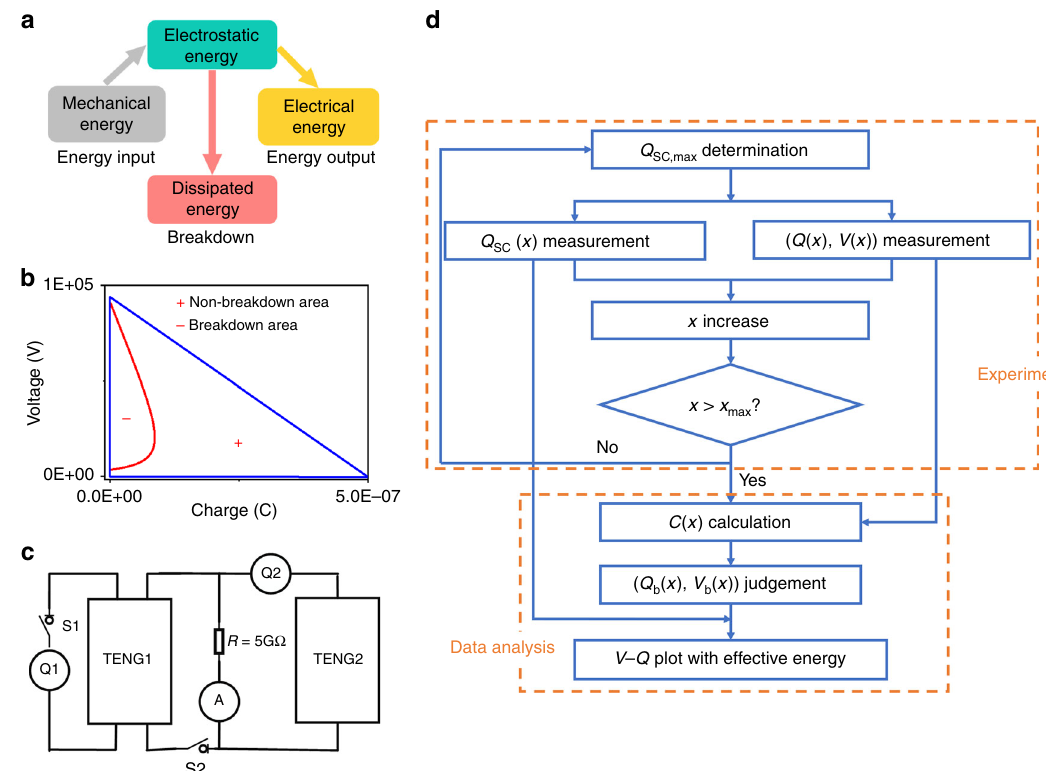
Fig. 1 Introduction of the method. a Energy fl ow chart of TENG system. b The V – Q plot at σ = 50 μ C m − 2 , showing the positive ( “ + ” ) part as the non- breakdown area and negative ( “ − ” ) part as the breakdown area. c Circuit of the universal method, with TENG2 being the power source and TENG1 being the target device. d Process fl ow chart of the universal